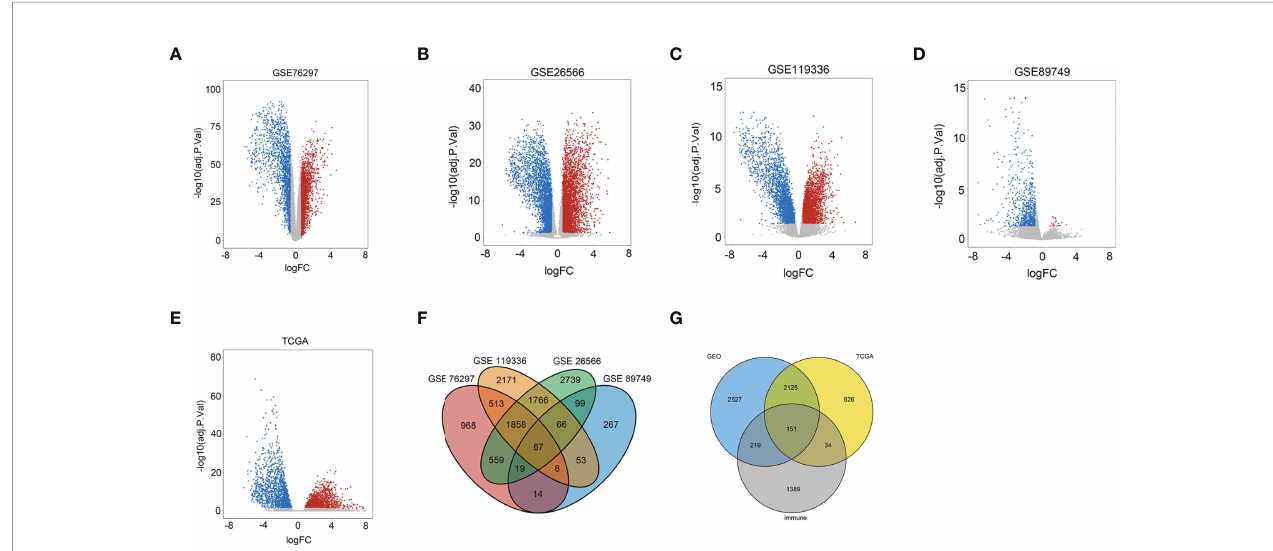
FIGURE 1 | Identi fi cation of immune-related differentially expressed genes in CCA from the dataset. (A) Volcano plots of DEGs in the GSE76297 dataset. (B) Volcano plots of DEGs in the GSE26566 dataset. (C) Volcano plots of DEGs in the GSE119336 dataset. (D) Volcano plots of DEGs in the GSE89749 dataset. (E) Volcano plots of DEGs in the TCGA dataset [ x -axis: log2(FC); y -axis: − log10(FDR) for each gene. Genes with FDR < 0.01 and FC >1.5 or < − 1.5 were considered as DEGs in TCGA. Blue: downregulated genes; Gray: non-differential genes; Red: upregulated genes]. (F) Overlapping analyses of DEGs in GSE76297, GSE26566, GSE119336, and GSE89749 groups; DEGs shared within 2 datasets or more were regarded as credible DEGs in each Venn diagram. (G) Overlapping analysis of GEO, TCGA, and ImmPort